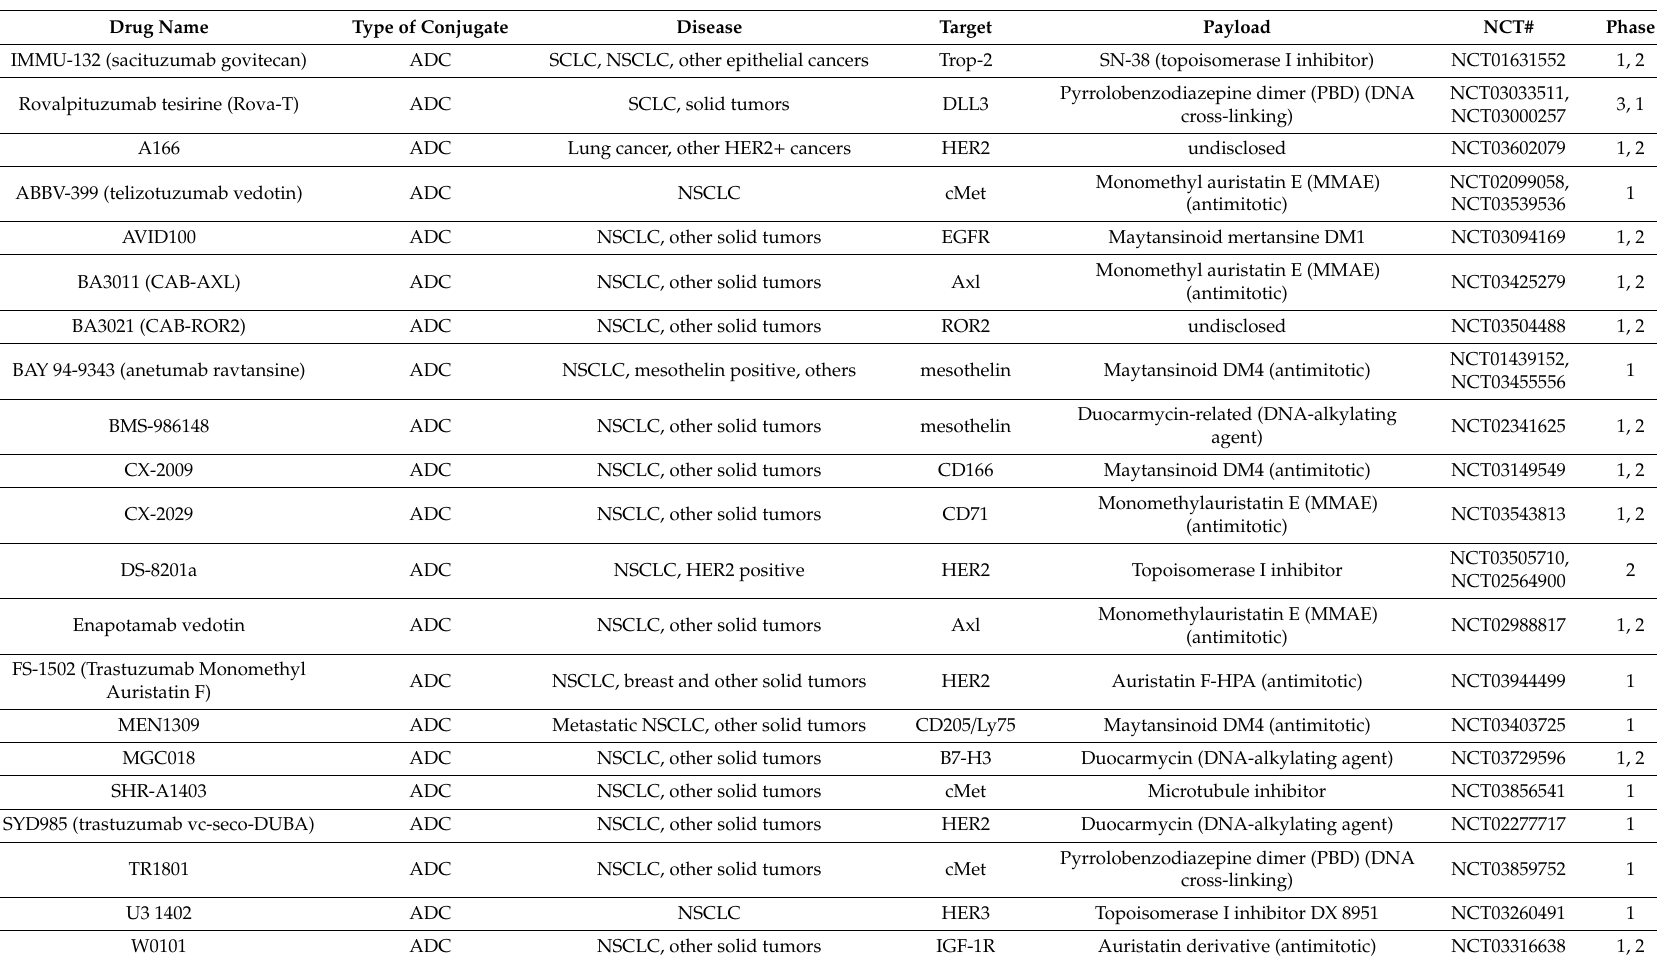
Table 1. List of active trials assessing tumor-targeted drug conjugates in lung cancers. ADC, antibody- drug conjugate; RIC, radioimmunoconjugate; PDC, polymer-drug conjugate; SMDC, small molecule- drug